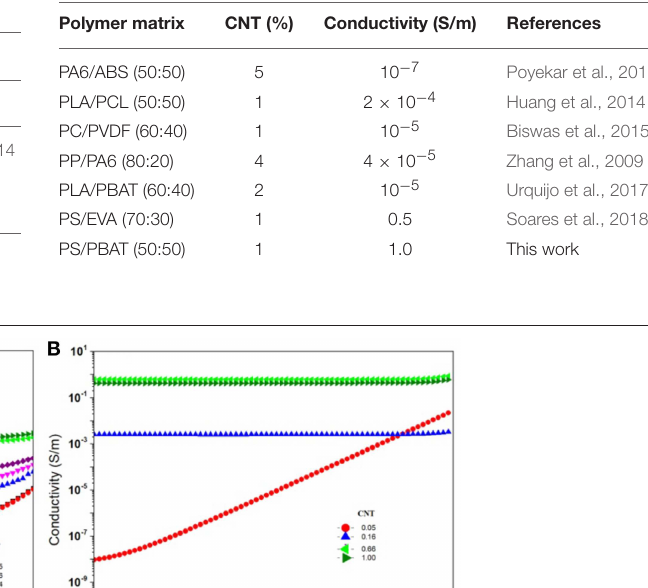
TABLE 4 | Conductivity values of CNT-thermoplastic systems prepared by melt mixing.